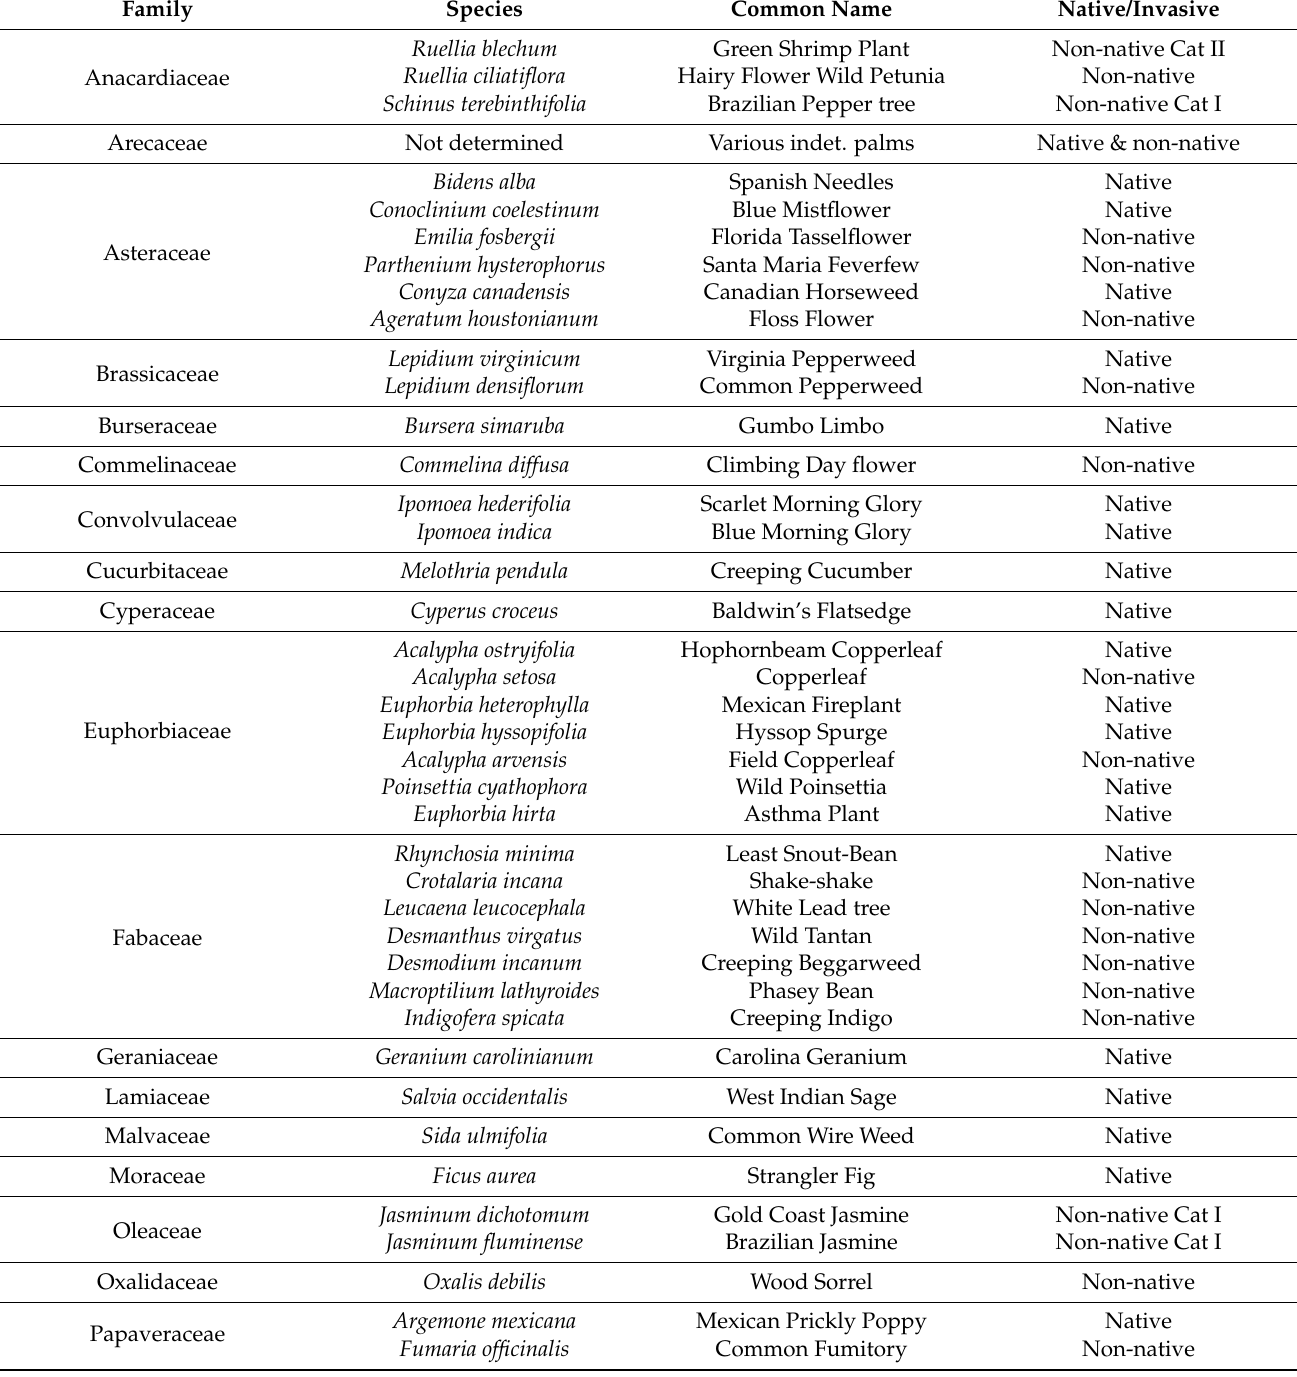
Table 4. Weed family and species in mango farm in Homestead, Florida,